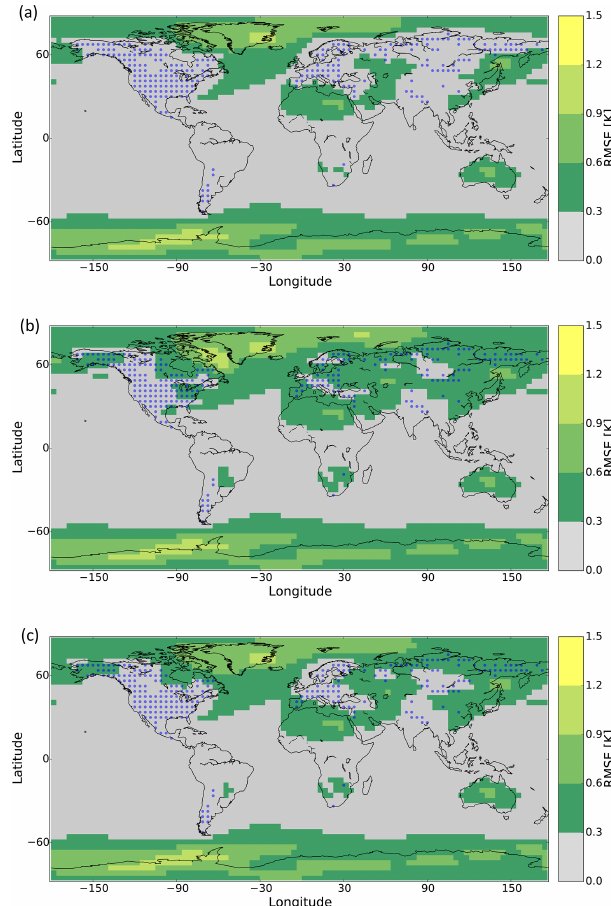
Figure 6. Yearly near-surface temperature RMSE for the anal- ysis of the ensemble runs using off-line DA and climatological soil moisture. (a) Assimilating VSL-T pseudo-TRW observations, (b) assimilating VSL-Min pseudo-TRW observations and (c) assim- ilating VSL-Prod pseudo-TRW